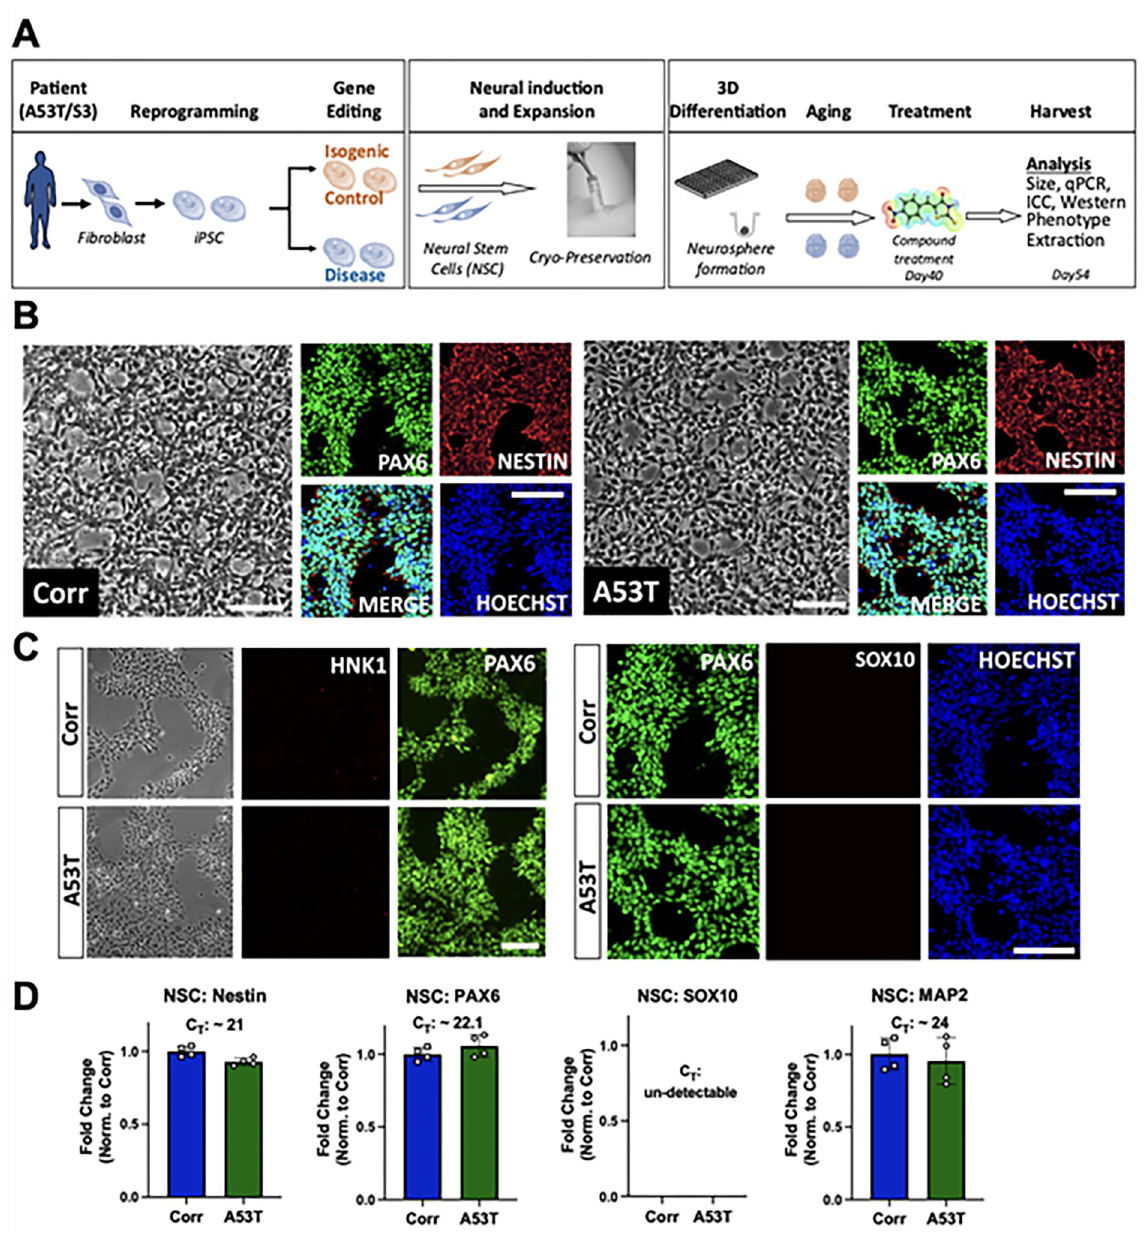
Fig 1. Process flow and quality control of Neural Stem Cells (NSC). A ) Process flow of patient-derived neurosphere generation. B ) Representative phase contrast images and immunocytochemistry (ICC) for Hoechst and NSC markers (Nestin and PAX6). Left Panel: Isogenic control line (Corr). Right panel: A53T line. Scale bar: 100 μ m. C ) ICC for Hoechst, PAX6, and neural crest cell markers (HNK1 and SOX10). Top panels: Isogenic control line (Corr). Bottom panels: A53T line. Scale bar: 100 μ m D ) Gene expression mRNA levels of Nestin, PAX6, SOX10 and MAP2 quantified using qPCR, normalized to a housekeeping control gene (GAPDH), and with fold changes measured relative to the isogenic control. qPCR data shows two biological replicates with two technical replicates each. Data is mean + standard deviation. https://doi.org/10.1371/journal.pone.0277532.g001 ( Fig 2A and S3A Fig in S1 File ). qPCR analysis showed the appropriate mRNA expression of differentiation stage markers at iPSC, NSC and neuron stage (S4 Fig in S1 File ). mRNA levels of relevant marker genes revealed no significant difference in levels of MAP2, Synapsin-I, S100B (astrocyte marker) and PAX6 in patient versus isogenic control neurospheres, while the